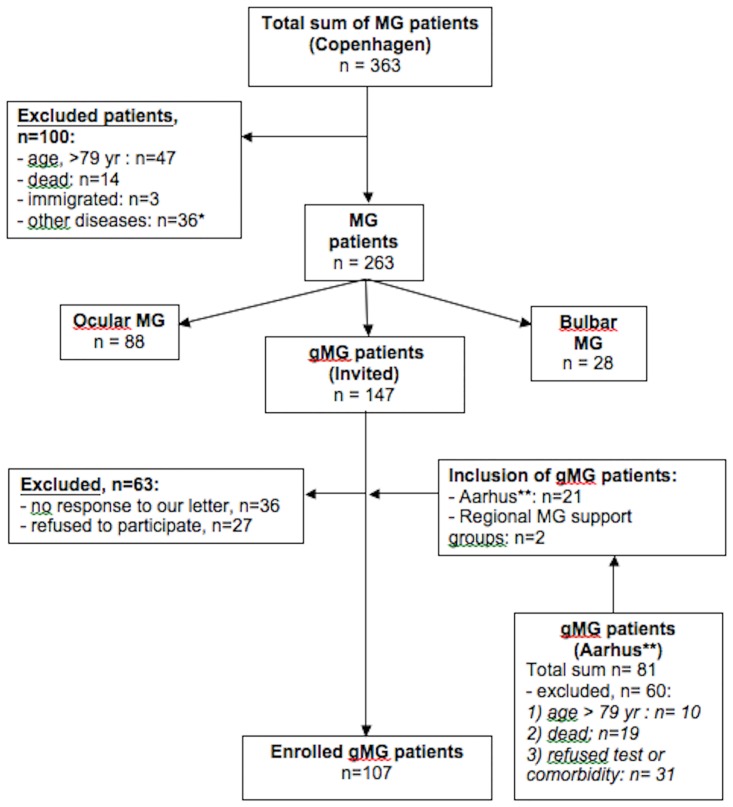
Flow chart of enrolled patients with generalized myasthenia gravis in the study.*Other diseases in the excluded patients included: Ehlers-Danlos syndrome (1 patient), severe osteoarthritis (6 patients), severe psychiatric diseases (1 patient), cancer (9 patients), other neurological diseases (19 patients). ** Patients examined in Aarhus, were primarily from outside Aarhus County.